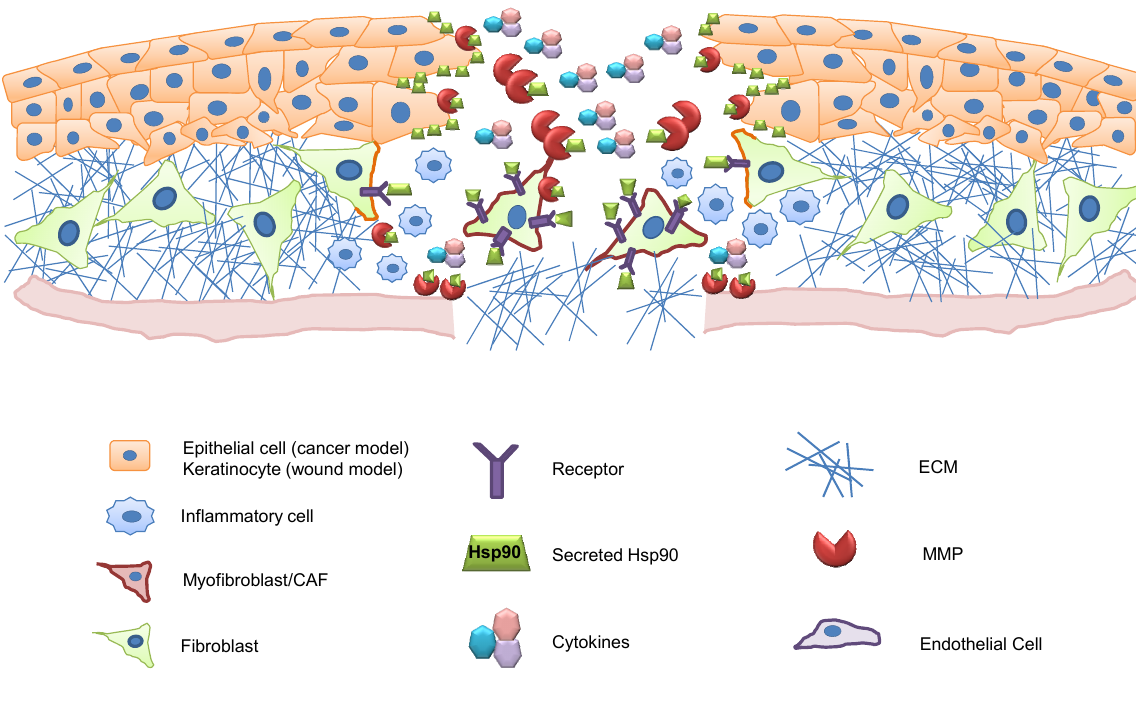
Figure 1. Role of eHsp90 in wound healing. Schema depicts a dermal wound, with the upper layer representing epidermal keratinocytes. Wounded keratinocytes demarking the wound edges secrete Hsp90 (green rectangles). Surface-localized Hsp90 initiates signaling events that promote cell motility into the wound bed. Surface and secreted eHsp90 also activate MMPs to facilitate wound closure, cytokine release, and vascular repair. In tandem, eHsp90-dependent signaling and eHsp90-activated MMPs collaborate to activate fibroblasts to a myofibroblastic-like state (depicted in red). Myofibroblasts are prevalent in close proximity to the wound site, whereas their activation diminishes at more distal sites, concomitant with reduced concentrations of eHsp90. Myofibroblasts play a key role in synthesizing the provisional matrix and creating an inflammatory milieu that is also important for host defense. Key for cell types is shown